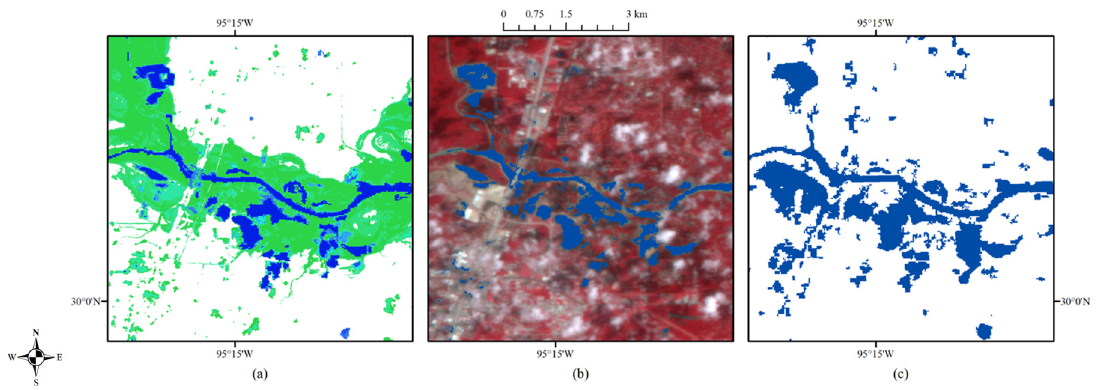
Figure 15. Enlarged site (E): inundation probability ( a ), the corresponding optical image on 1 September ( b ), and ( c ) FEMA flood map, with water shown in blue.